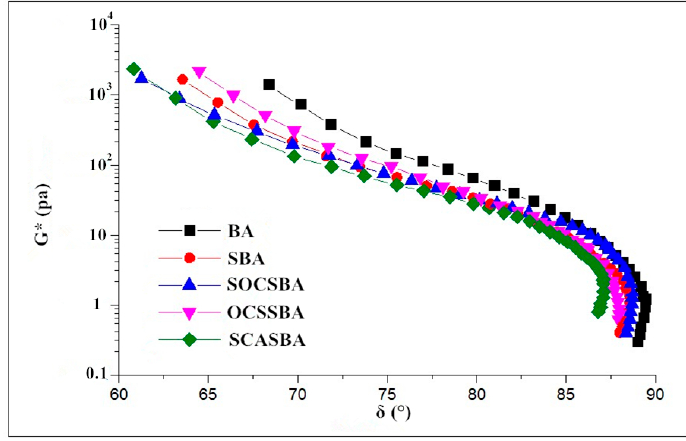
Figure 13. Black diagram for five modified asphalt binders.